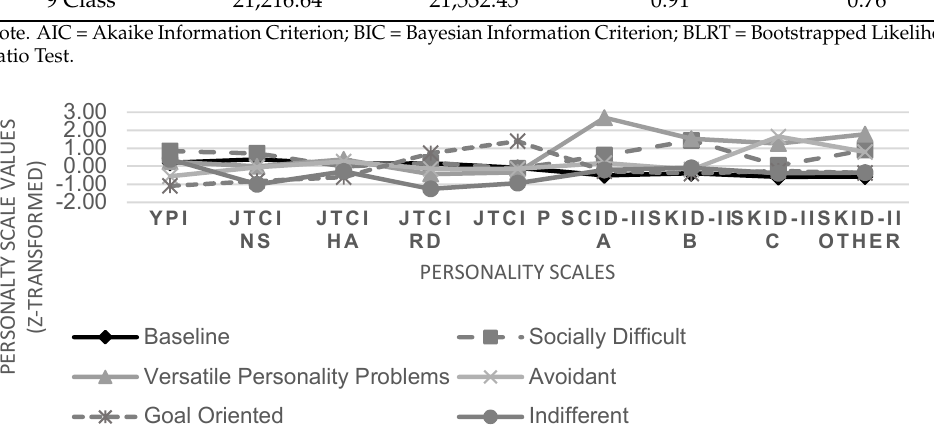
Figure 1. LPA six-profile model based on YPI, JTCI temperament scales, and dimensional SCID-II cluster ratings (z-transformed).